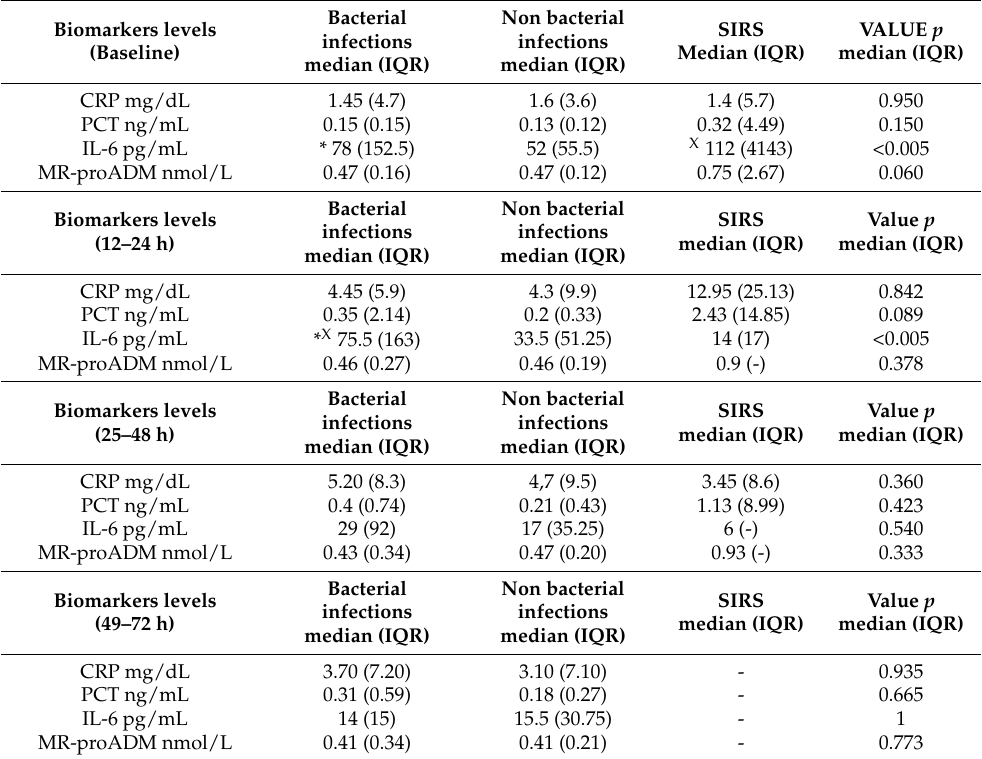
Table 3. C-Reactive Protein, Procalcitonin, IL-6 and MR-proADM levels in episodes with bacte- rial infection, systemic inflammatory response syndrome, and no bacterial infection in the four analytical controls.